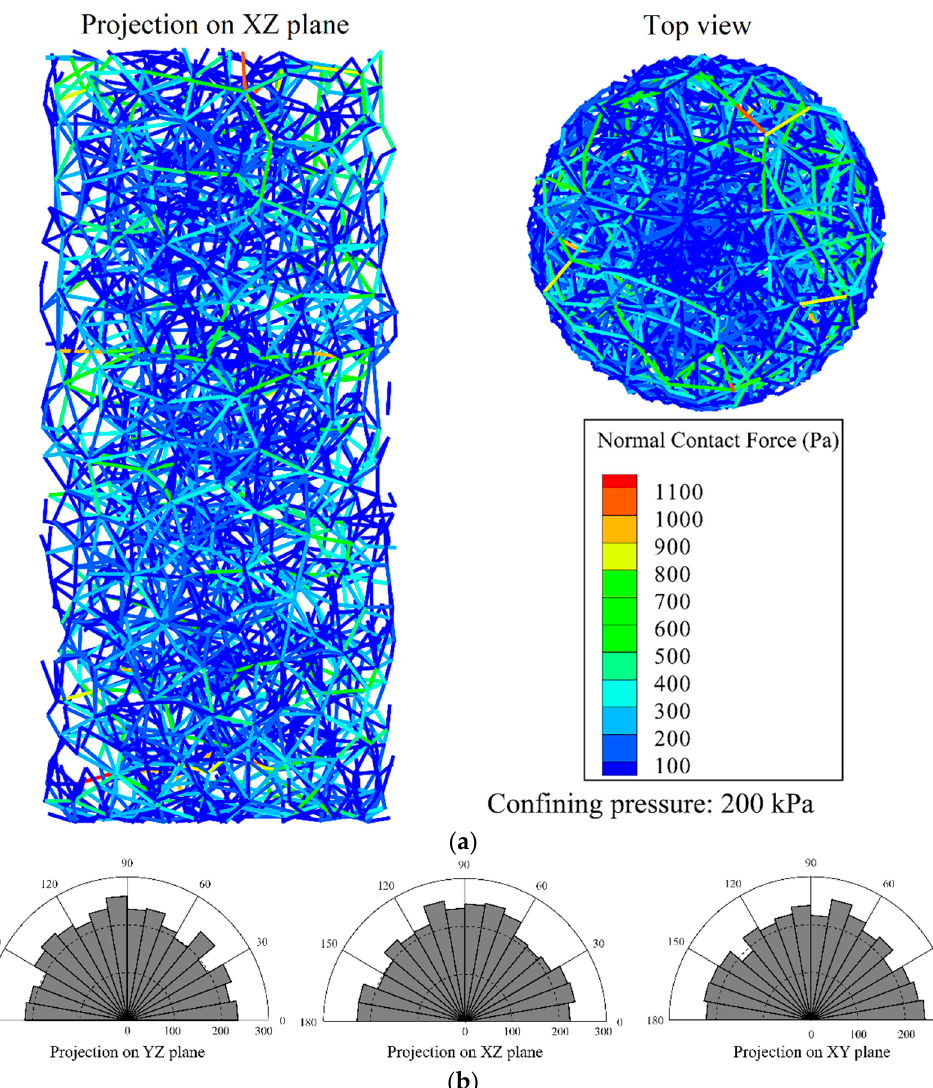
Figure 9. Micro-structure of the cobble sample during isotropic compression (confining pressure: 200 kPa): ( a ) distribution of the force-chain; and ( b ) rose plot of the contact direction in particles.